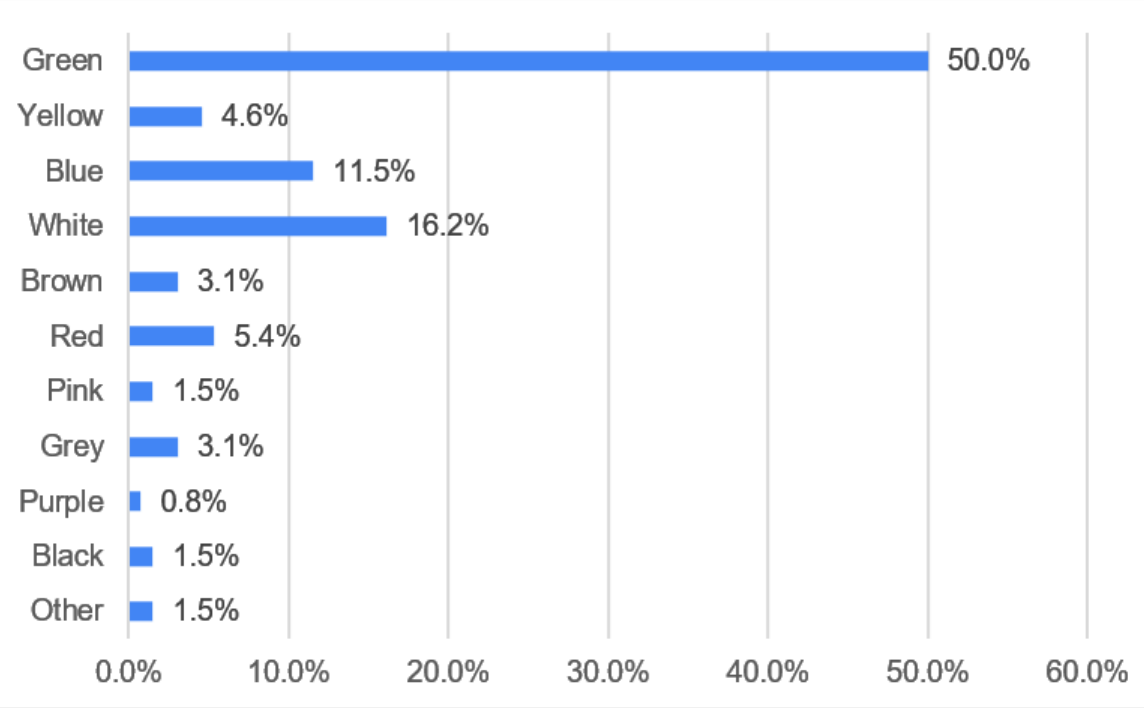
Figure 4. Colour preference by gender. When participants were asked in which area of a supermarket they would place a healthy snack, 60.0% ( n = 78) of them responded that it should be located in the “healthy products” section and 5 2.3% ( n = 68) responded that it should be found in the “snacks” section (see Figure 5). Considering the whole sample, 60.5% of participants who selected “price” in RQ1 chose “snacks section” as their desired section to place a healthy snack product (x 2(1, N=130) = 6.78, p = 0.009).